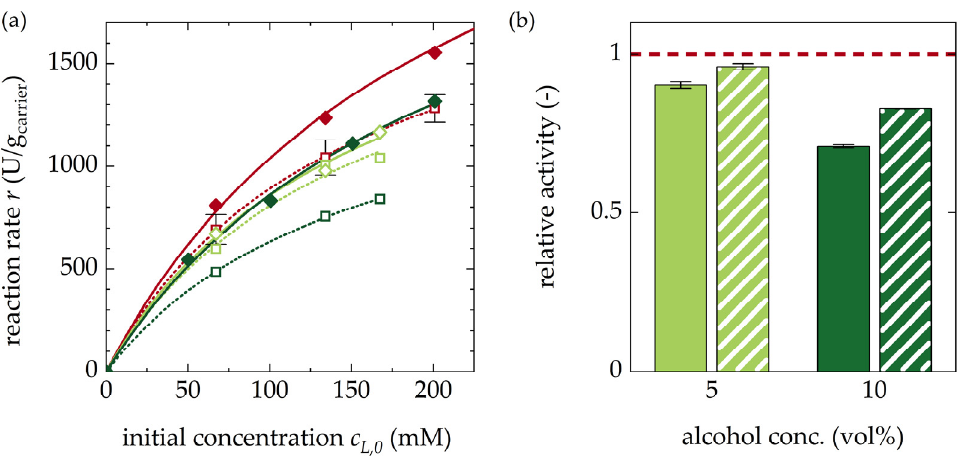
Figure 4. ( a ) Reaction rates for L -Met with 5 and 10 vol% ethanol or methanol in the solvent in reference to the reaction rates without alcohol. Batch 1: solid dots, batch 2: hollow dots. Ethanol: solid lines, methanol: dotted lines. 0 vol%: red, 5 vol%: light green, 10 vol%: dark green. ( b ) Average activities for 5 and 10 vol% EtOH (solid) and MeOH (hatched) normalized to the activity of the respective batch without alcohol.